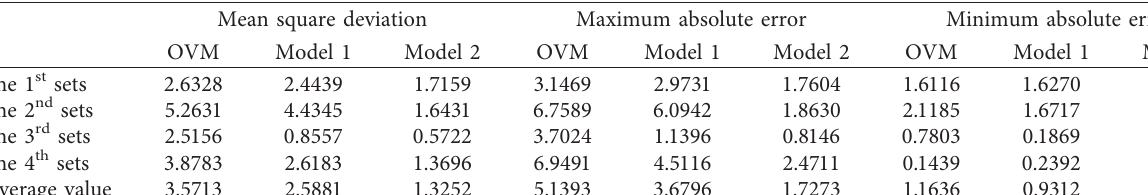
Table 8: Comparison of evaluation indexes.